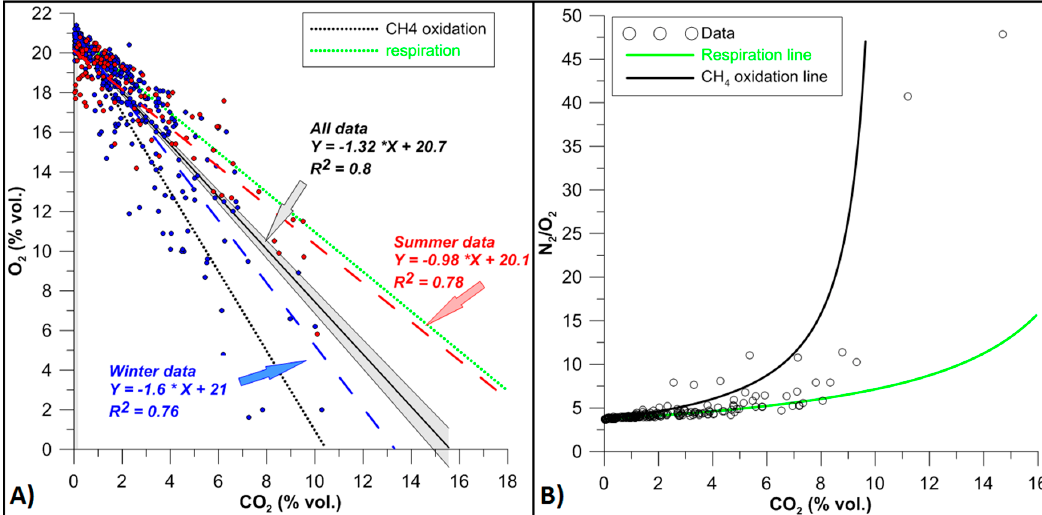
Figure 5. ( A ) Relationship between CO 2 and O 2 in soil gas and comparison to source attribution protocol defined by [59]; ( B ) Relationship between CO 2 and N 2 /O 2 in soil gas. Data fits are compared with control lines corresponding to CH 4 oxidation and respiration processes.